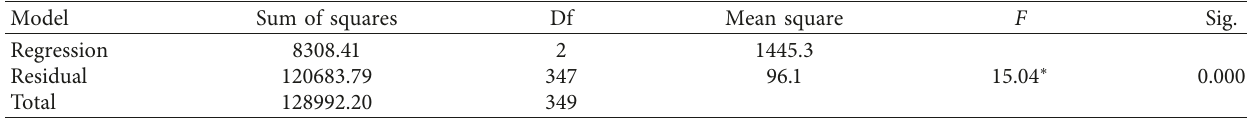
Table 2: Multiple regression analysis showing the composite contribution of independent variables on students’ achievement in